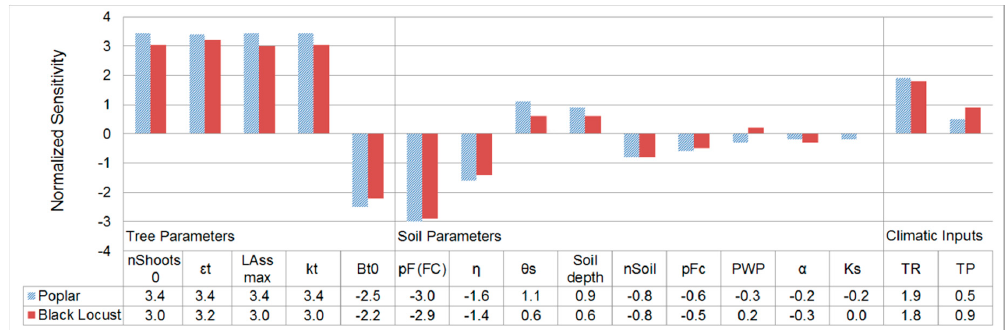
Figure 1. The normalized sensitivity of the model’s output to tree and soil parameters, as well as to climatic inputs for both poplar and black locust. Tree parameters include the initial number of shoots ( nShoot 0 ), radiation use efficiency ( ε t ), maximum leaf area for a single shoot ( LA ssmax ), radiation extinction coefficient ( k t ), and the initial biomass (B t0 ). The soil parameters consist of the pF value at field capacity ( pF ( FC )), potential evaporation ( η ), saturated volumetric water content ( θ s ), soil depth,